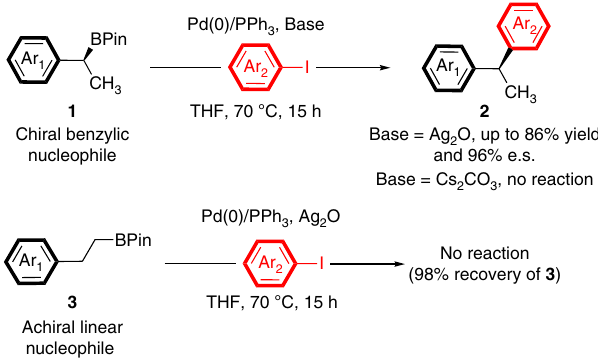
Figure 2 | Orthogonal reactivity of branched benzylic and linear aliphatic boronic esters. Observation of complete inversion of reactivity such that branched benzylic boronic esters ( 1 ) react in the presence of Ag 2 O, but not carbonate bases, while linear aliphatic isomers ( 3 ) are recovered unchanged when treated with Ag 2